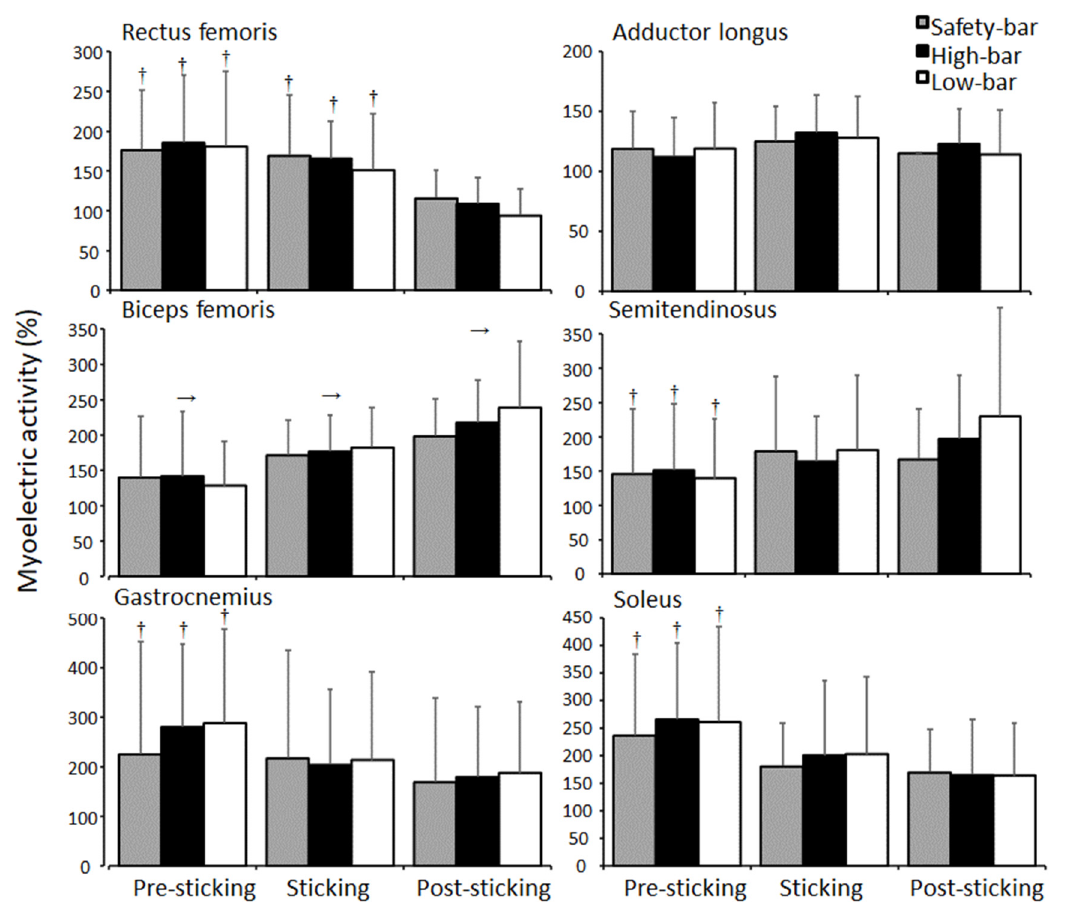
Figure 8. Mean ± SD normalised myoelectric activity for rectus femoris, adductor longus, biceps femoris, semitendinosus, gastrocnemius, and soleus during pre-sticking, sticking, and post-sticking region for the high-bar, low-bar, and safety-bar squat during 3-RM. → indicates a significant difference between this region and all other regions for all squat conditions on a p ≤ 0.05 level. † indicates a significant difference between this region and the post-sticking region for all squat conditions on a p ≤ 0.05 level.